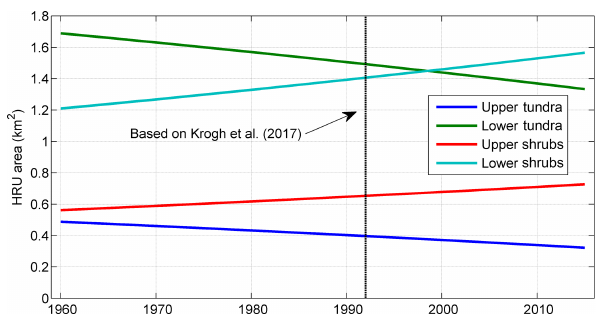
Figure 3. Annual changes in the tundra and shrub HRUs area used in the CRHM-AHM